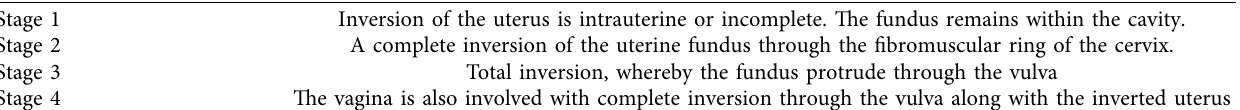
Table 2: Stages of uterine